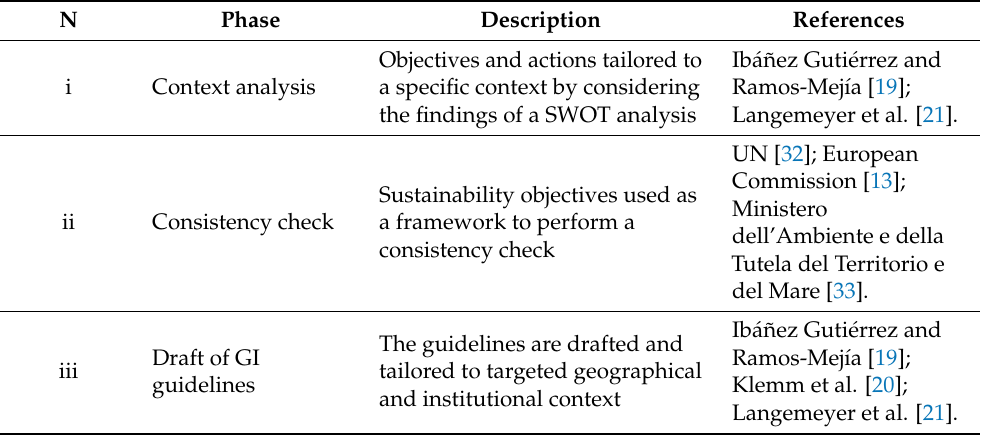
Table 1. Method proposed for the drafting of GI guidelines (after De Montis et al.